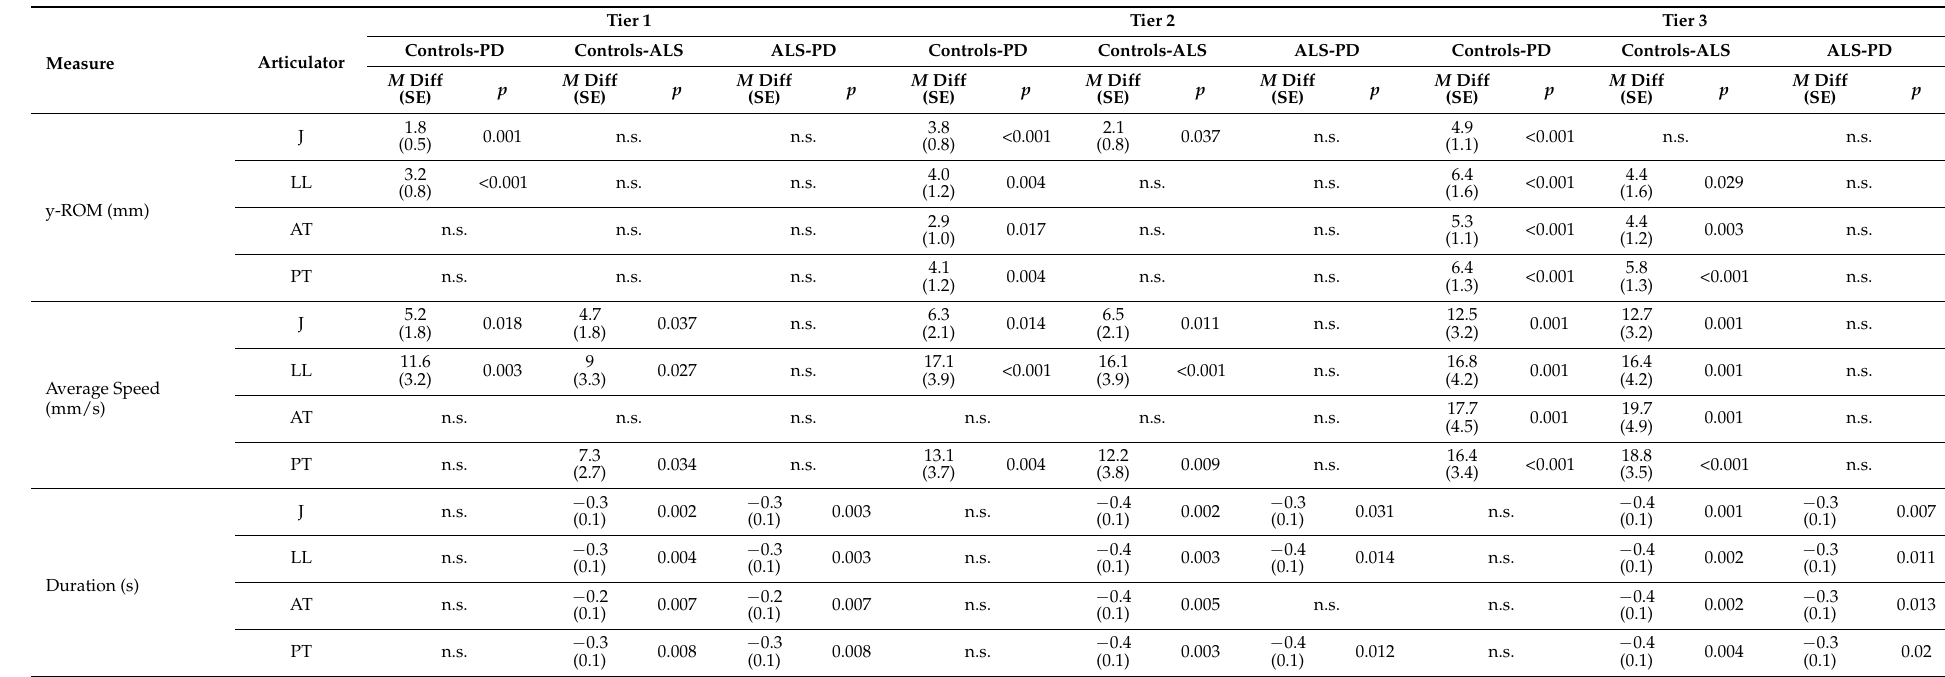
Table 4. Results of post hoc analyses for tier x group interactions (i.e., between-group